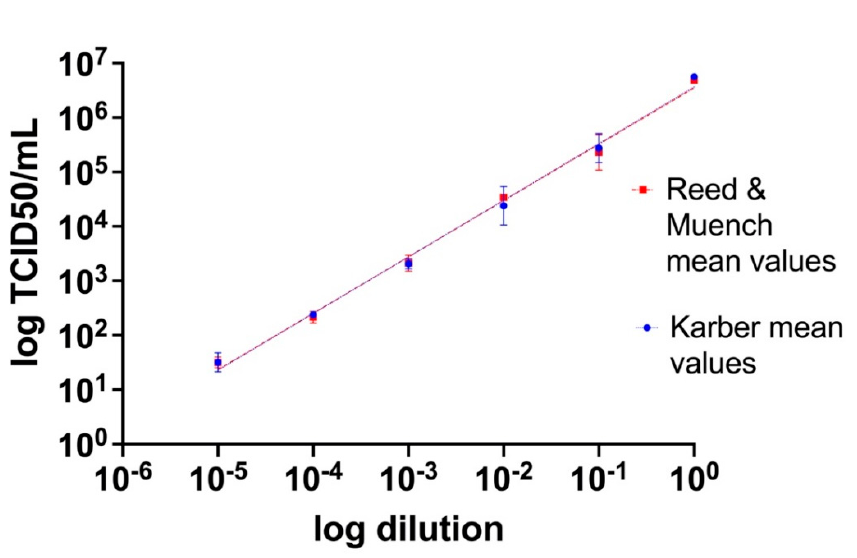
Figure 3. Tissue culture infecting dose per mL (TCID50/mL) values obtained by titration on Vero E6 cell cultures of scalar dilutions of the viral stock. TCID50/mL values are presented as the mean of the two different methods (Reed and Muench and Karber) of two replicates for each dilution ± SE.